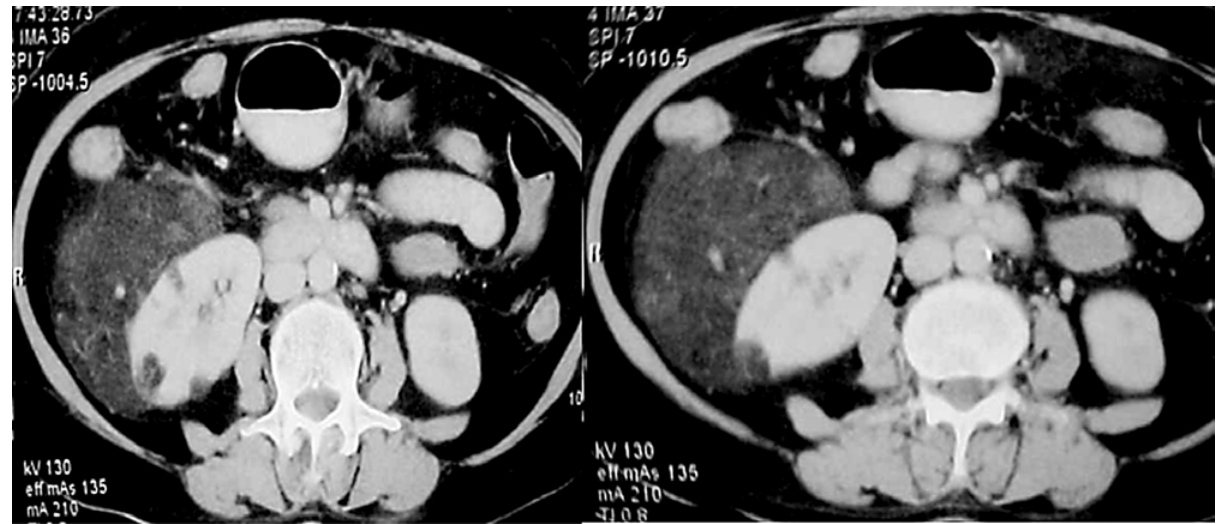
Figure 2 – Perinephric tumor with fat attenuation in relation with the right kidney